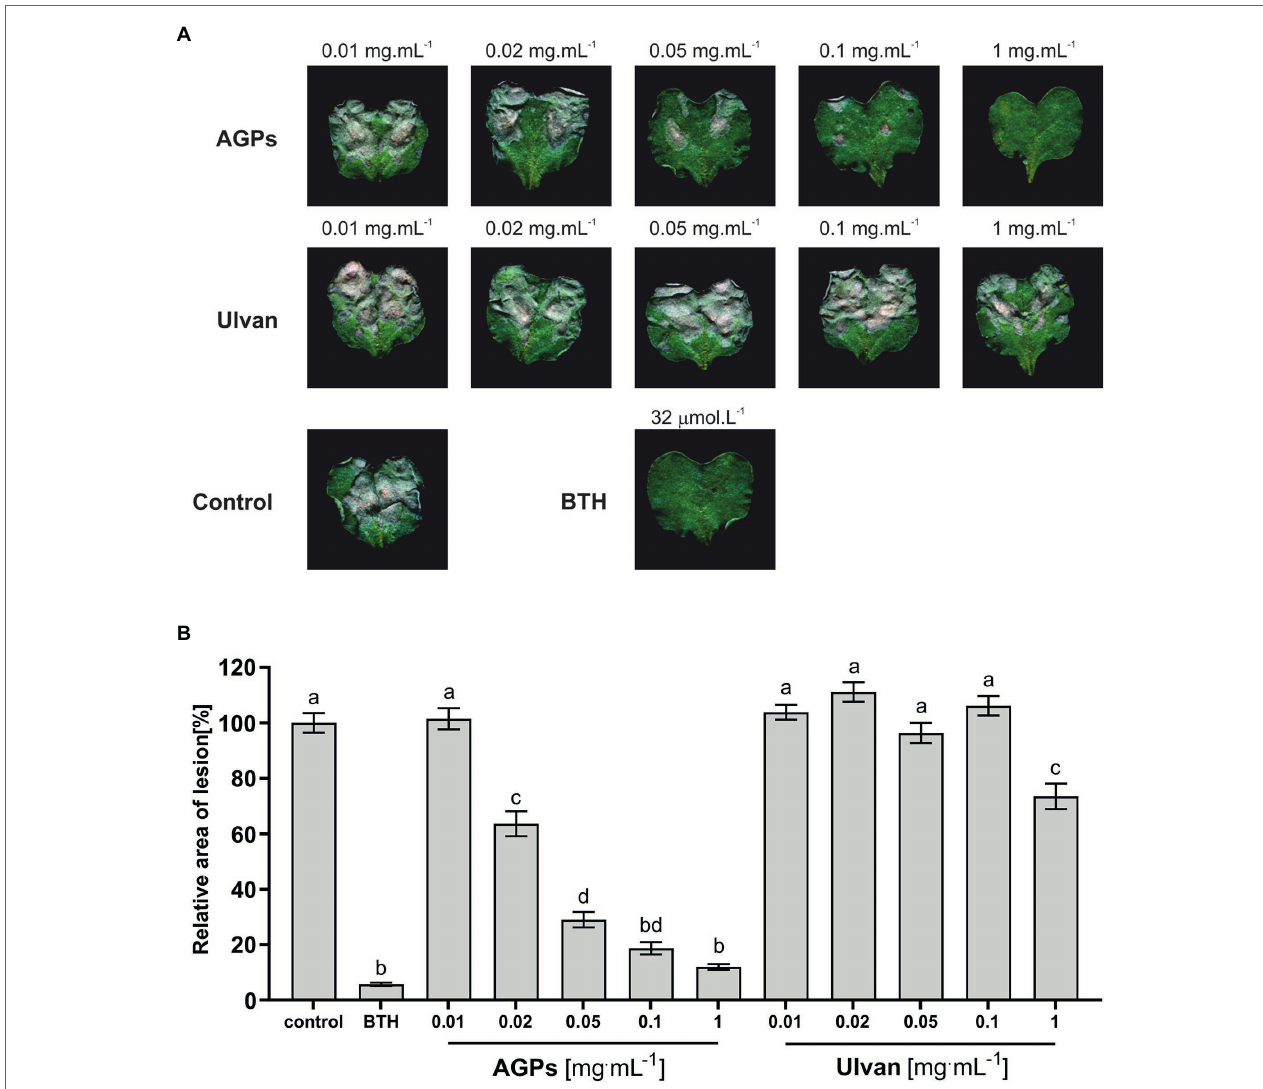
FIGURE 2 | Effect of algal elicitors on the progression of L. maculans infection in B. napus cotyledons. Cotyledons were treated with AGP-like enriched fraction (AGPs), ulvan extracted according to Yaich et al. (2013) (Ulvan), distilled water (negative control), and 32 μ M BTH (benzothiadiazole, positive control) 2 days before inoculation with L. maculans . Symptoms of L. maculans infection on cotyledons of B. napus 11 days after inoculation (A) . Disease symptoms were evaluated as a percentage of the lesion area to the leaf area 11 days after inoculation (B) . The algal elicitors were tested in concentrations 0.01, 0.02, 0.05, 0.1, and 1 mg·ml − 1 . The graph presented data from three biological replicates. Statistically significant differences determined by the one-way ANOVA and Tukey post-hoc test ( p < 0.05). Each column is presented as the mean ± SE ( n = 72). Different letters indicate significant